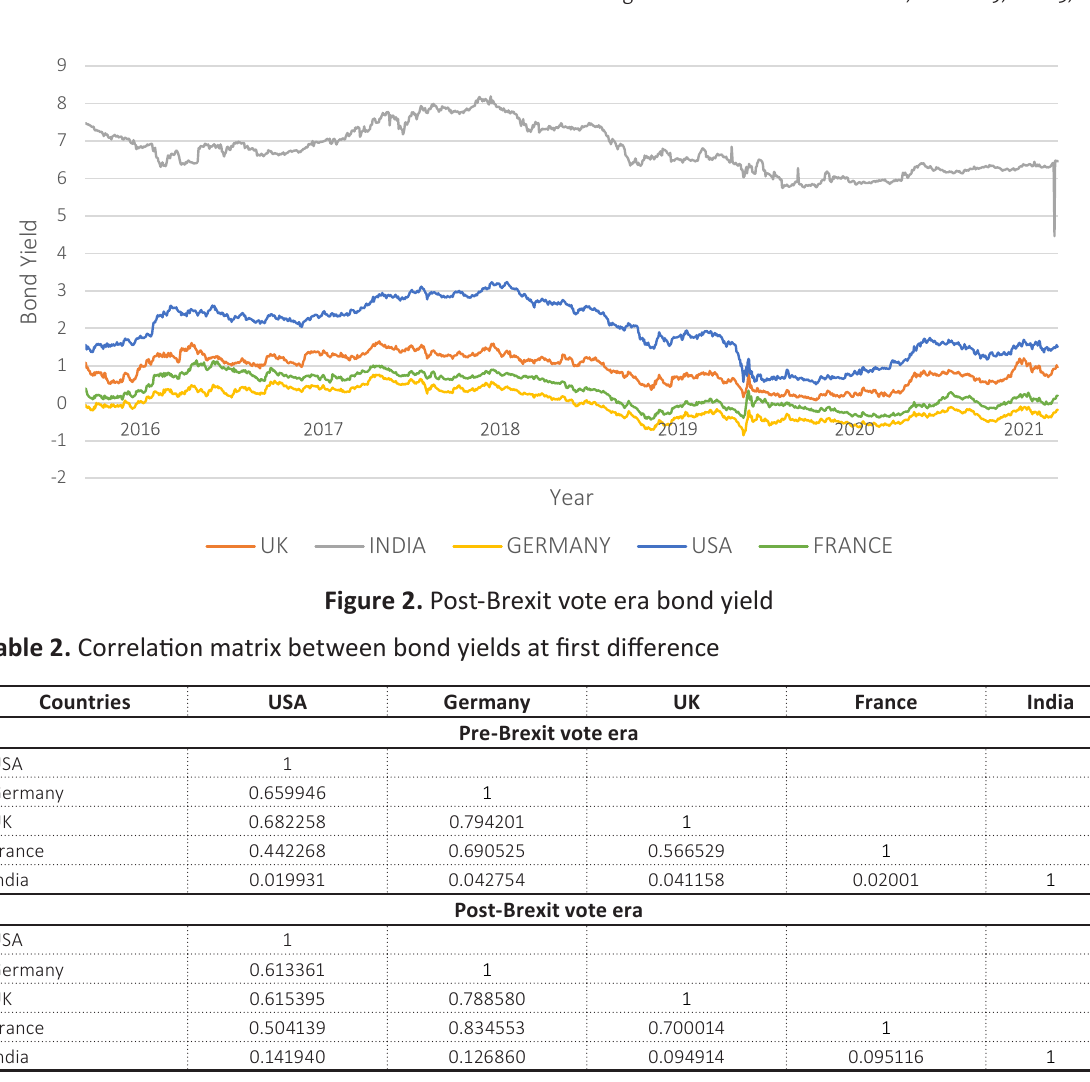
Table 3. VAR parameters for the pre-Brexit vote era